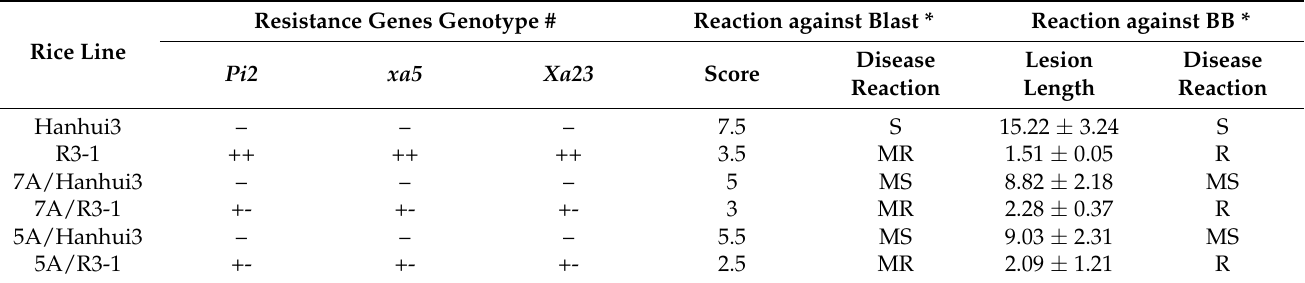
Table 2. Blast and bacterial blight resistance of the improved NIL and its derived hybrids.